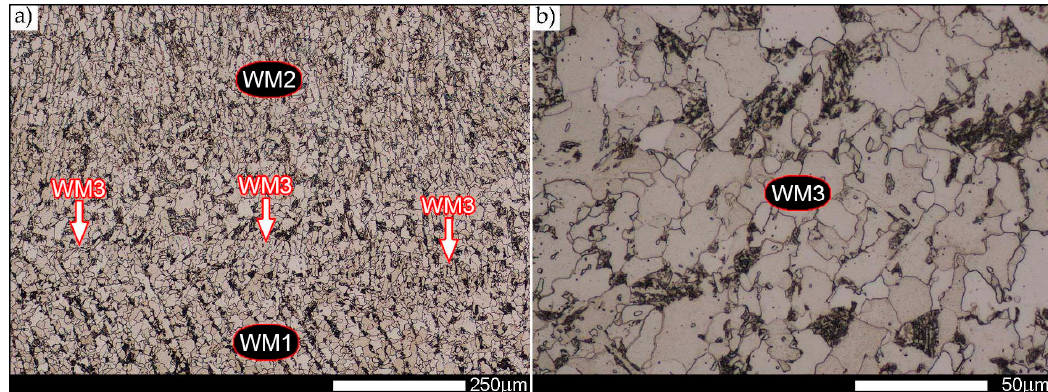
Figure 15. Welded joint microstructure of Hardox 450 steel in the normalised state—WM2 zone shown in Figure 2b. ( a ) 100 × ; ( b ) 500 × . Structure consisting of near-equilibrium ferrite grains with pearlite with minor banded structure features and tertiary cementite precipitates at ferrite grain boundaries. Light microscopy, etched with 3% HNO 3 .